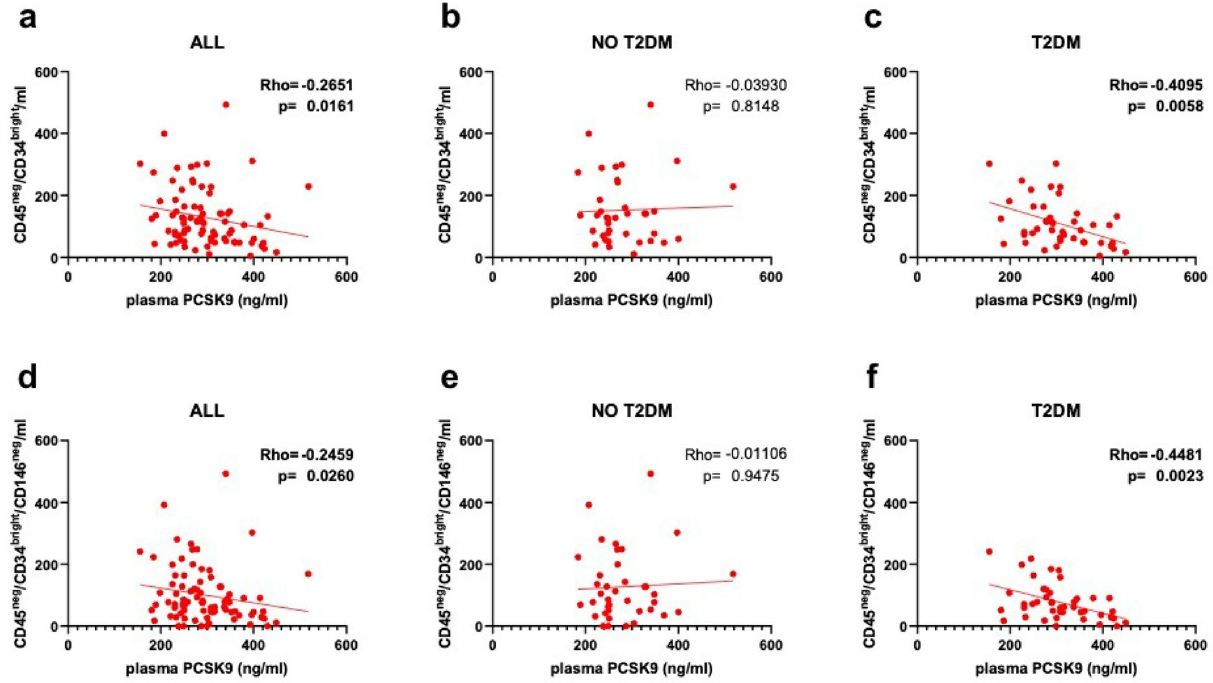
Figure 3. Plasma PCSK9 and EPCs. Correlations between levels of plasma PCSK9 and number of CD45 neg / CD34 bright (top) and CD45 neg /CD34 bright /CD146 neg (bottom) in patients considered as a whole ( a , d ) and in those without ( b , e ) and with T2DM ( c , f